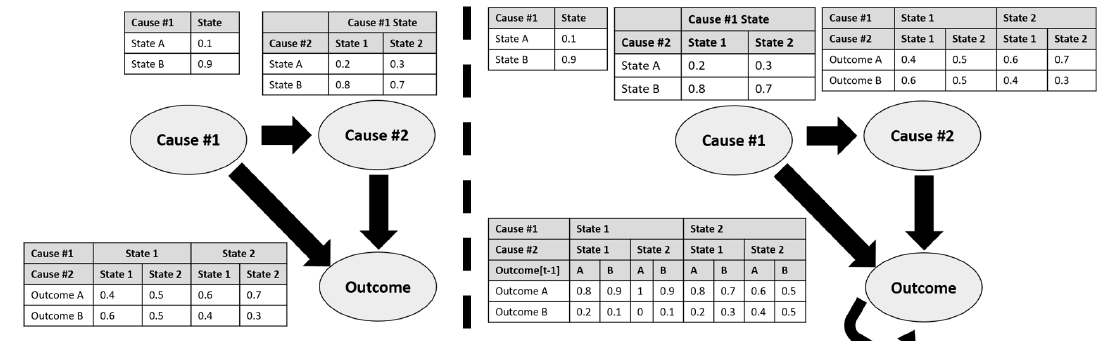
Figure 2. Sample static Bayesian network (left) and dynamic Bayesian network (DBN) (right). Both models have a relationship structure of nodes and directed arcs as well as conditional probability tables for those relationships; however, dynamic nodes within the DBN also need an initial distribution for their